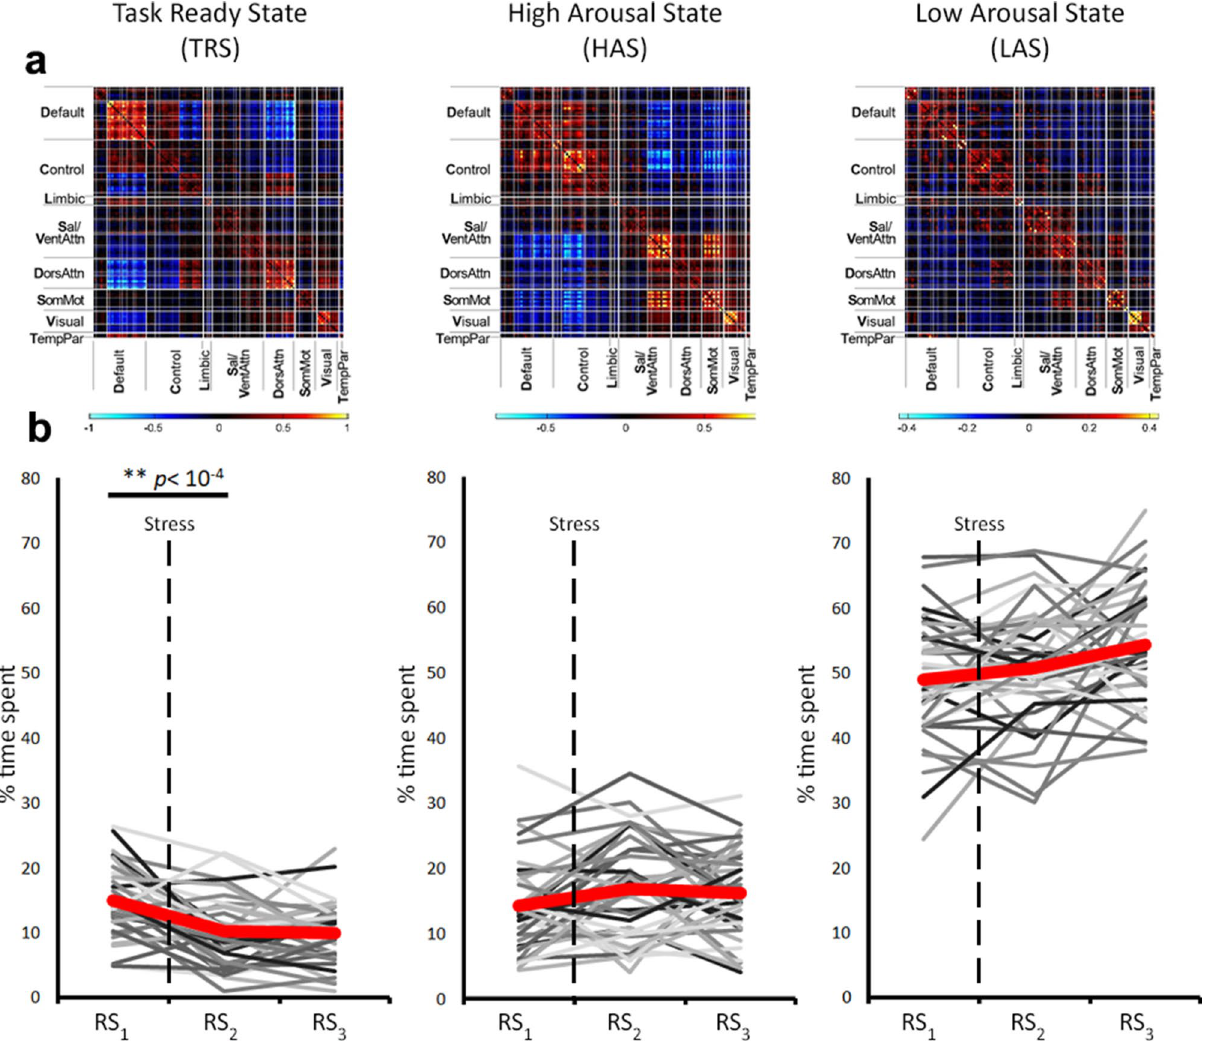
Figure 2. ( a ) Connectivity centroids of the task-ready state (TRS), high arousal state (HAS) and low arousal state (LAS). ( b ) Individual trajectories and grand means of changes in the states over the three resting-state scans. Significant differences were found between RS 1 and RS 2 for the